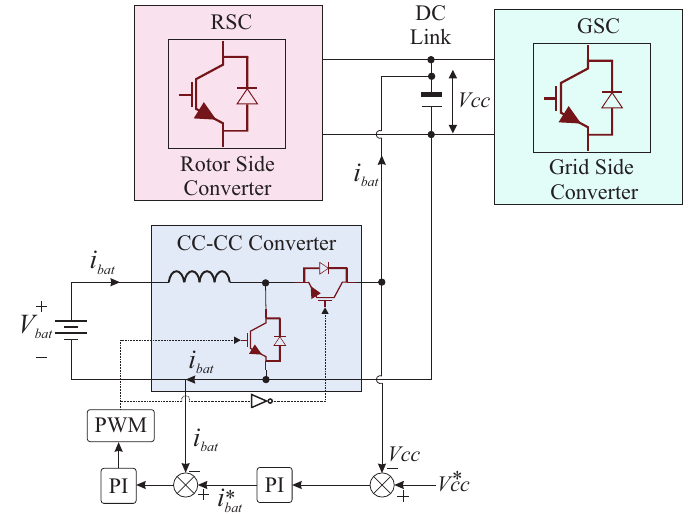
Figure 4. Control diagram for